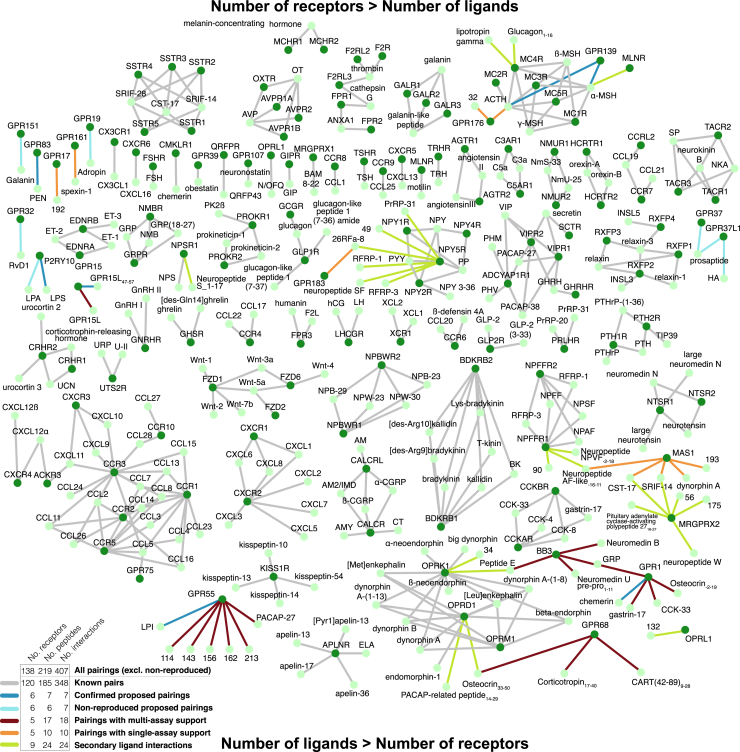
Expansion of the Human Peptidergic Receptor Signaling SystemThe new pairings (colored lines) increase the number of known ligand-receptor connections (edges) from 348 to 407 (putative peptide ligands from 185 to 214 and putative peptide receptors from 120 to 130). Ligand-receptor systems are shown with increasing ligand-to-receptor ratios (top to bottom). There are more ligands per receptor in both the established and novel peptidergic receptor systems.